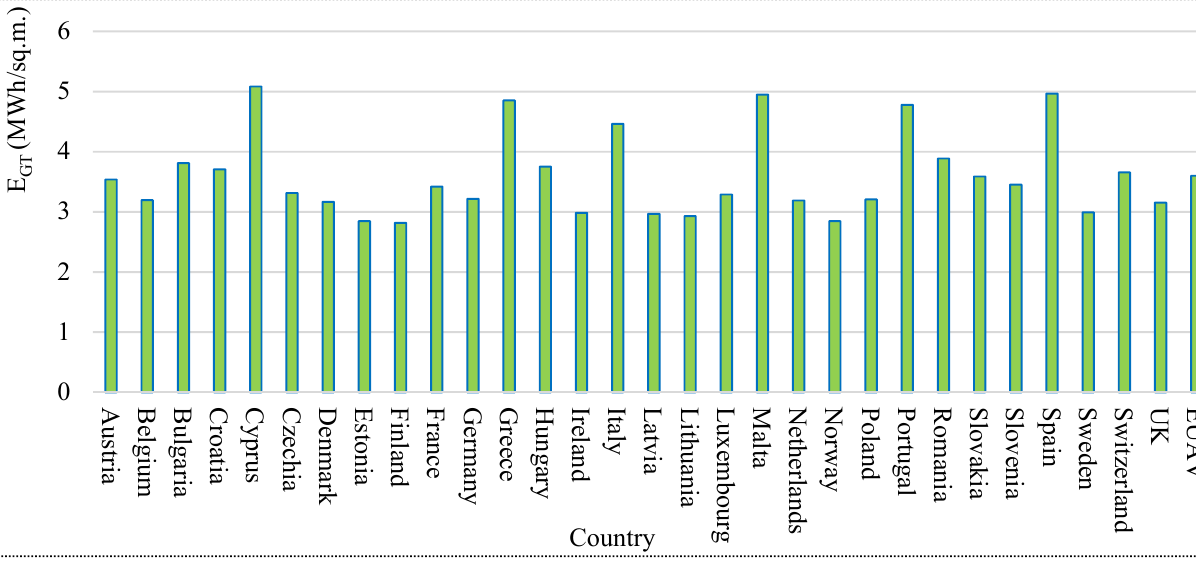
Figure 2. Lifetime electricity production of the BIPV system (E GT ) as building envelope material. Table 2. System financial analysis in Europe.